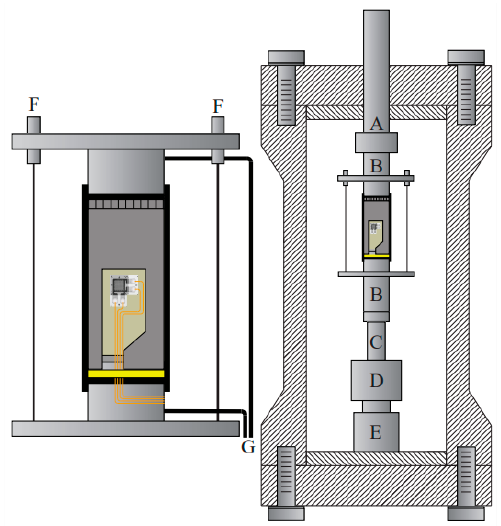
Figure 2. Low-frequency rig at SINTEF. A: piston, B: top and bottom endcaps with embedded P- and S-wave transducers, C: piezoelectric force sensor, D: piezoelectric actuator, E: internal load cell, F: LVDTs, and G: pore fluid lines.